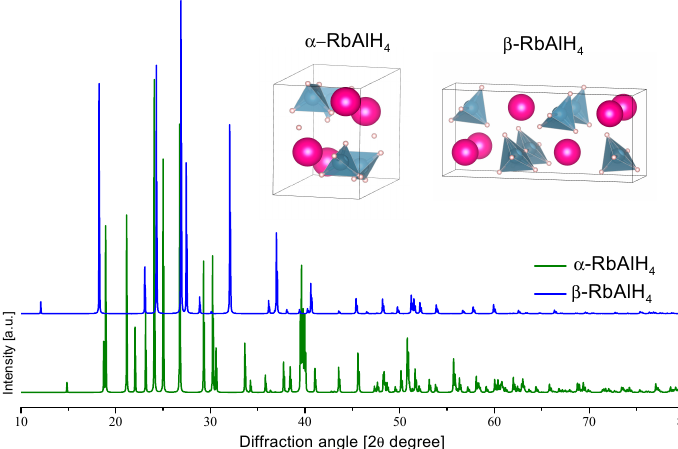
ff raction patterns ( λ = Cu k α 1